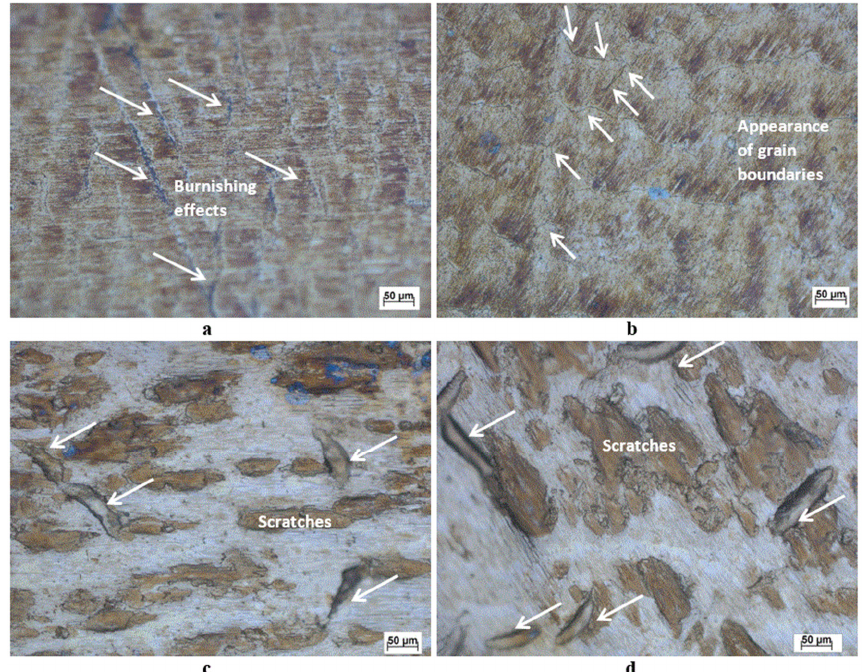
Figure 6. Topography for 400-grit burnished surfaces at different passes and locations. ( a ) A single pass 5 mm from the center; ( b ) a single pass 15 mm from the center; ( c ) four passes 5 mm from the center; ( d ) four passes 15 mm from the center.